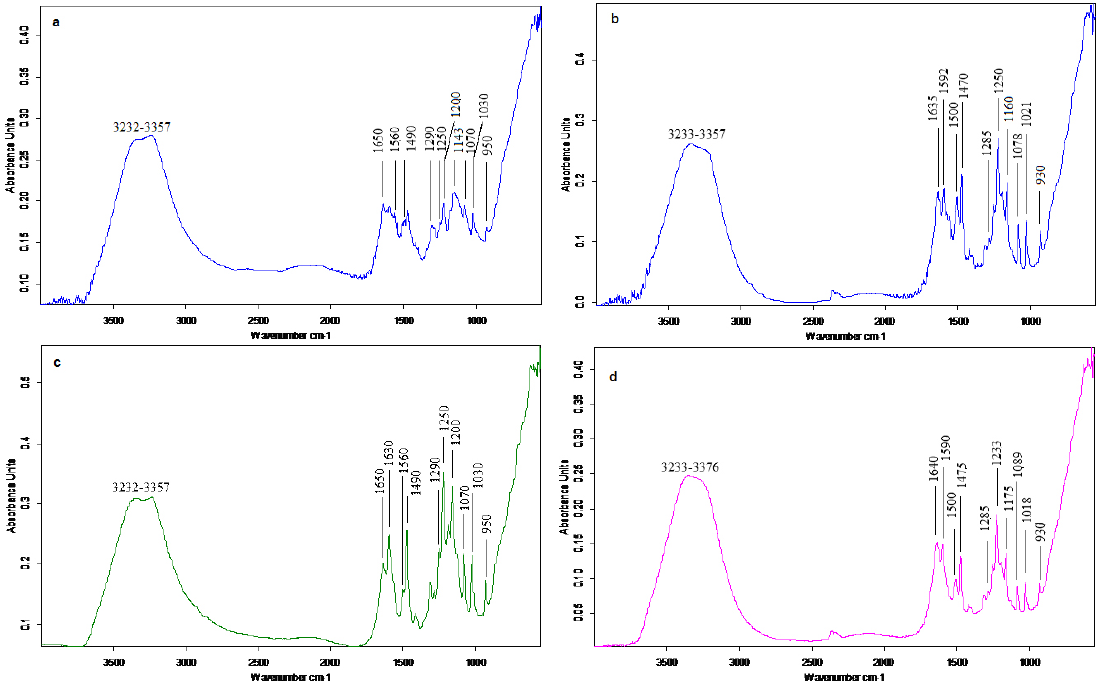
Figure 3. FT-IR spectra for the composite membranes: a) aniline polymerization, b) p-phenylenediamine polymerization and of composite membranes with the conductive polymer doped with polystyrene sulfonic acid: c) sPEEK/PANi membrane, d) sPEEK/PpPD